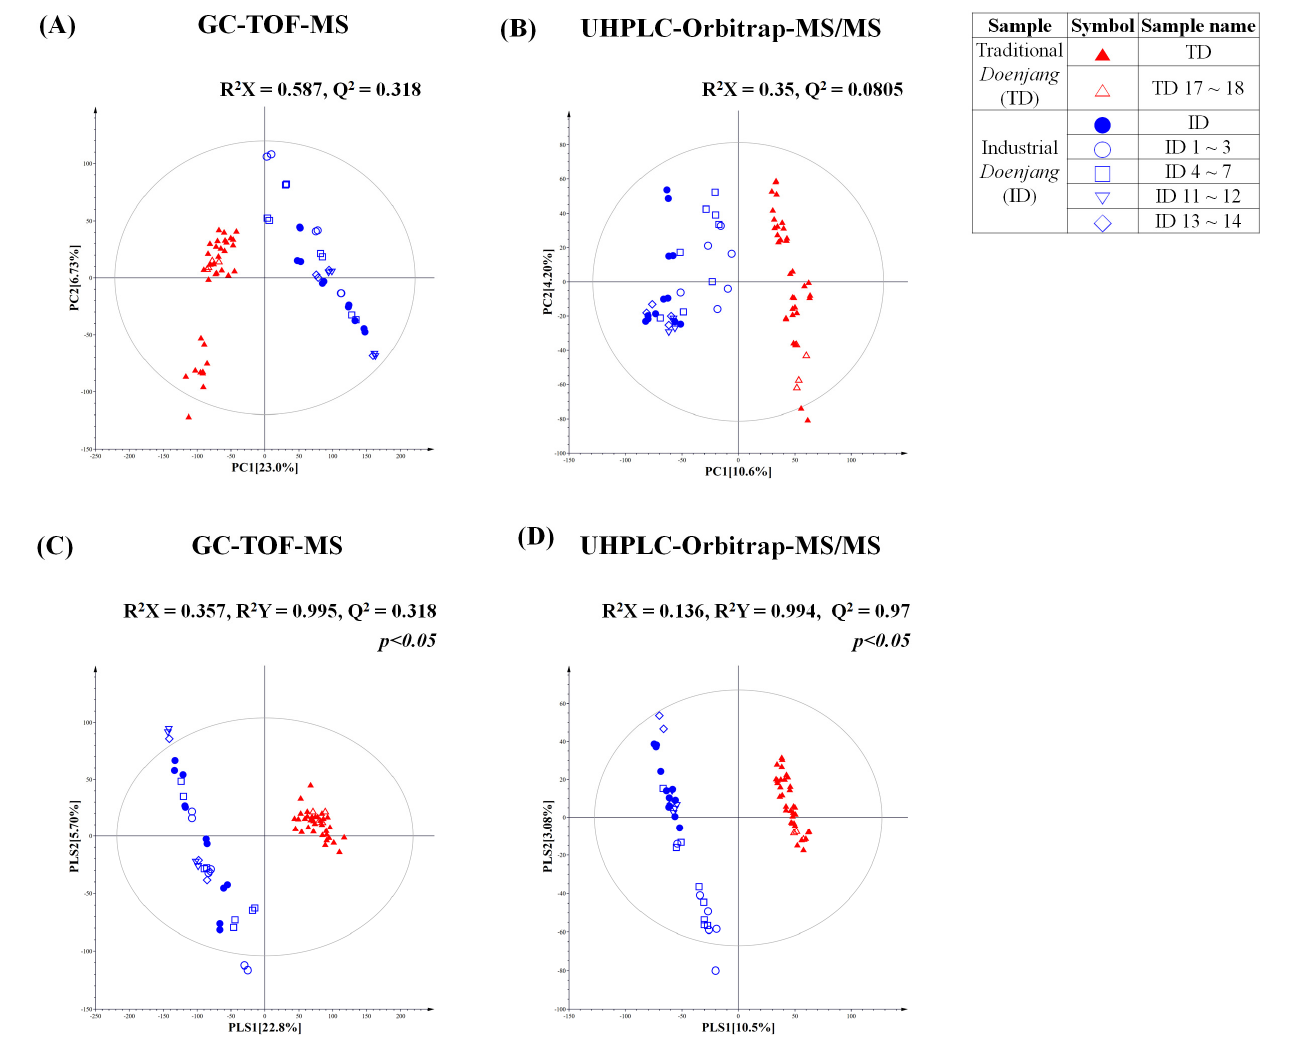
Figure 1. PCA and PLS-DA score plots of traditional and industrial doenjang ( ▲ ( TD): traditional doenjang , ● (ID): industrial doenjang ) based on GC-TOF-MS ( A , C ) and UHPLC-Orbitrap-MS/MS ( B , D ). Unfilled symbols represent samples from the same manufacturers.